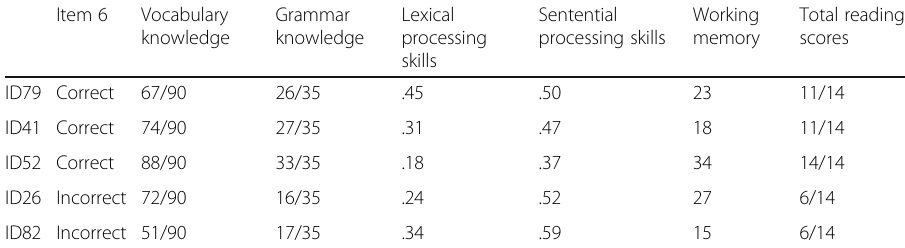
Table 12 The sub-reading abilities of each test taker from item 6 Item